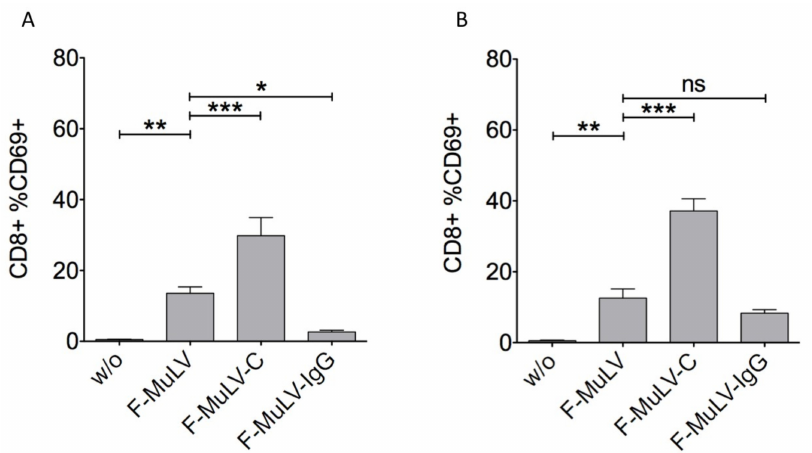
Figure 1. IgG-opsonization of Friend murine leukemia virus (F-MuLV) diminishes activation of virus-specific CD8 T cells by bone marrow-derived dendritic cells (bmDCs) but not by B cells. 5 × 10 5 ( A ) DCs or ( B ) B cells were loaded with 5000 FFUs of F-MuLV or an equivalent of C’- or IgG-opsonized F-MuLV (F-MuLV-C or F-MuLV-IgG, respectively) based on viral RNA. DCs or B cells were cocultured with 5 × 10 5 isolated FV-specific TCRtg CD8 T cells. Activation of CD8 T cells was determined by the expression of the early activation marker CD69 gating on AAD-negative living CD8 singlets measured by flow cytometry after 48 h of coculture. Bars represent mean ± SEM of five independent experiments. Data were analyzed by GraphPad PRISM (version 7) software (GraphPad Software, San Diego, CA, USA) using ANOVA followed by Dunnet’s multiple comparison test (***, **, * significant at p < 0.001, p < 0.01, p < 0.05,